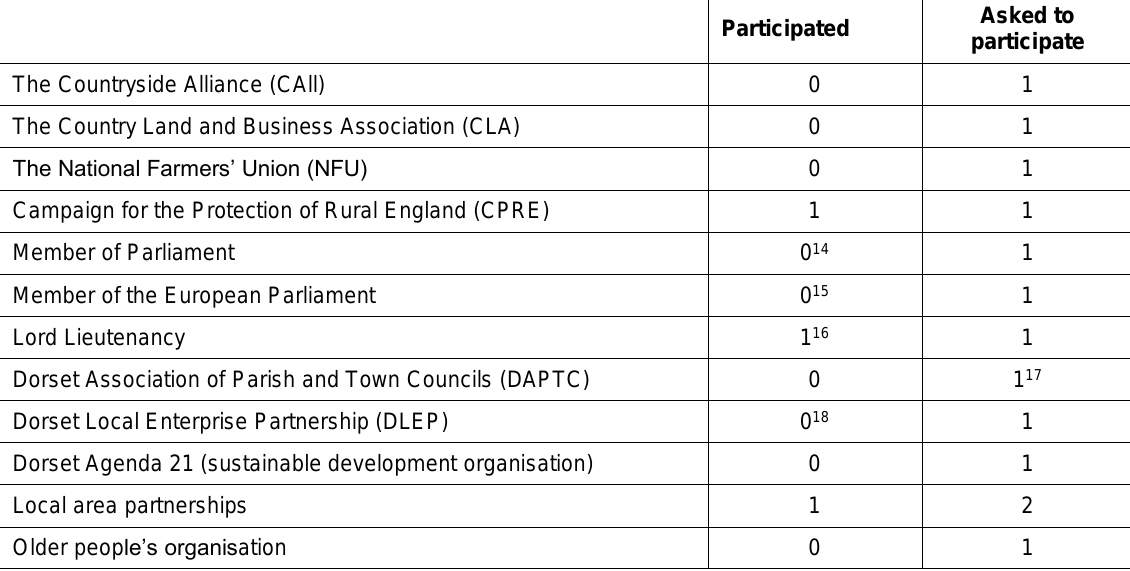
Table 3: Other organisations/individuals asked to participate 13